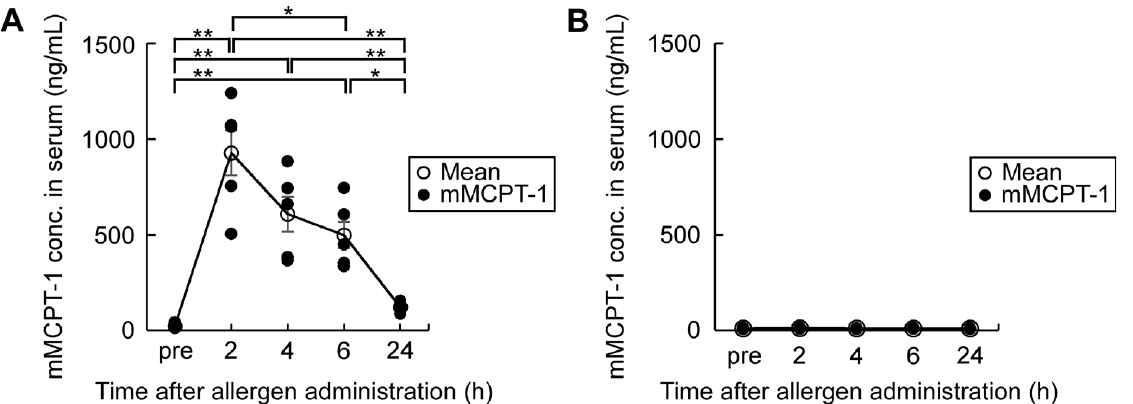
Figure 6. Serial changes in serum mMCPT-1 levels before and after oral administration of 20 mg OVM and ASA pre-medication at 50 mg/kg. ( A ) Changes in mMCPT-1 levels in sensitized mice ( n = 5/group); ( B ) Changes in mMCPT-1 levels in naïve mice ( n = 6/group). Data are mean ± SEMs. * p < 0.05, ** p <